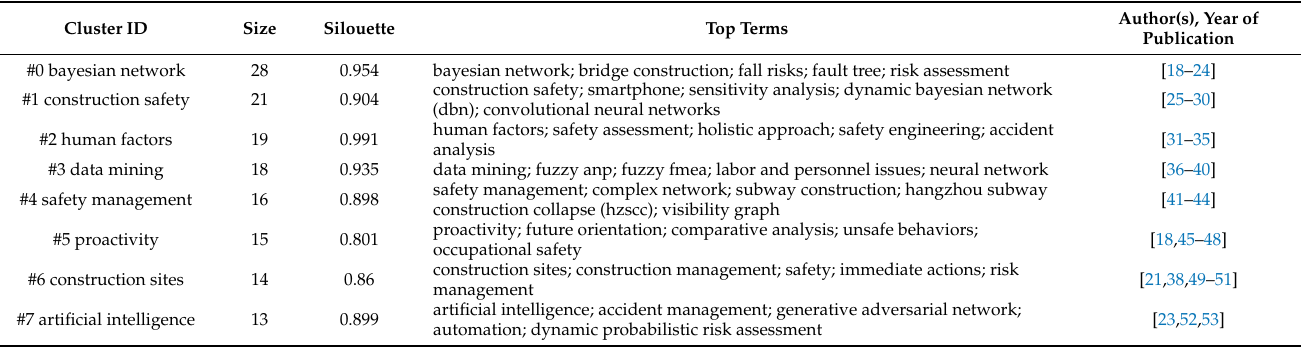
Figure 4. Network of keyword clusters. Table 4. Keyword cluster